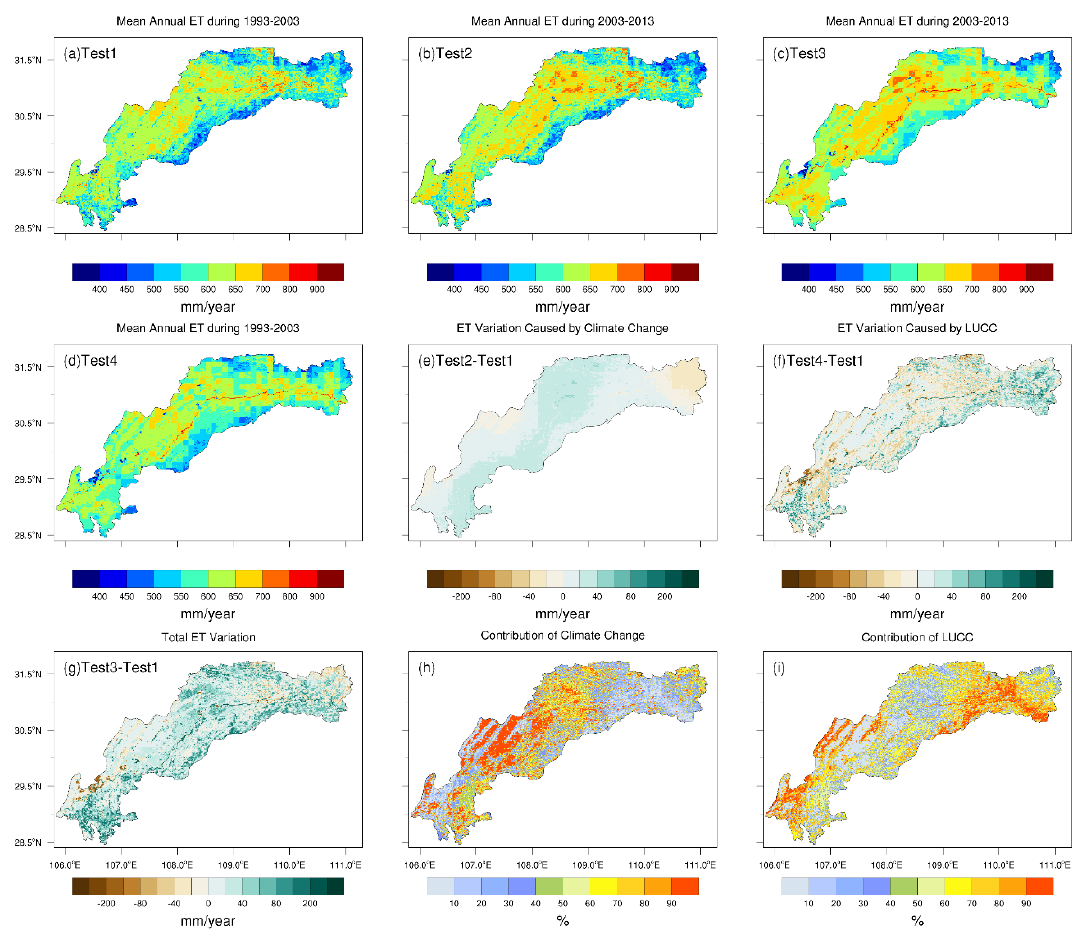
Figure 11. The spatial differences and the contribution of climate change and LUCC to total ET before and after impoundment.